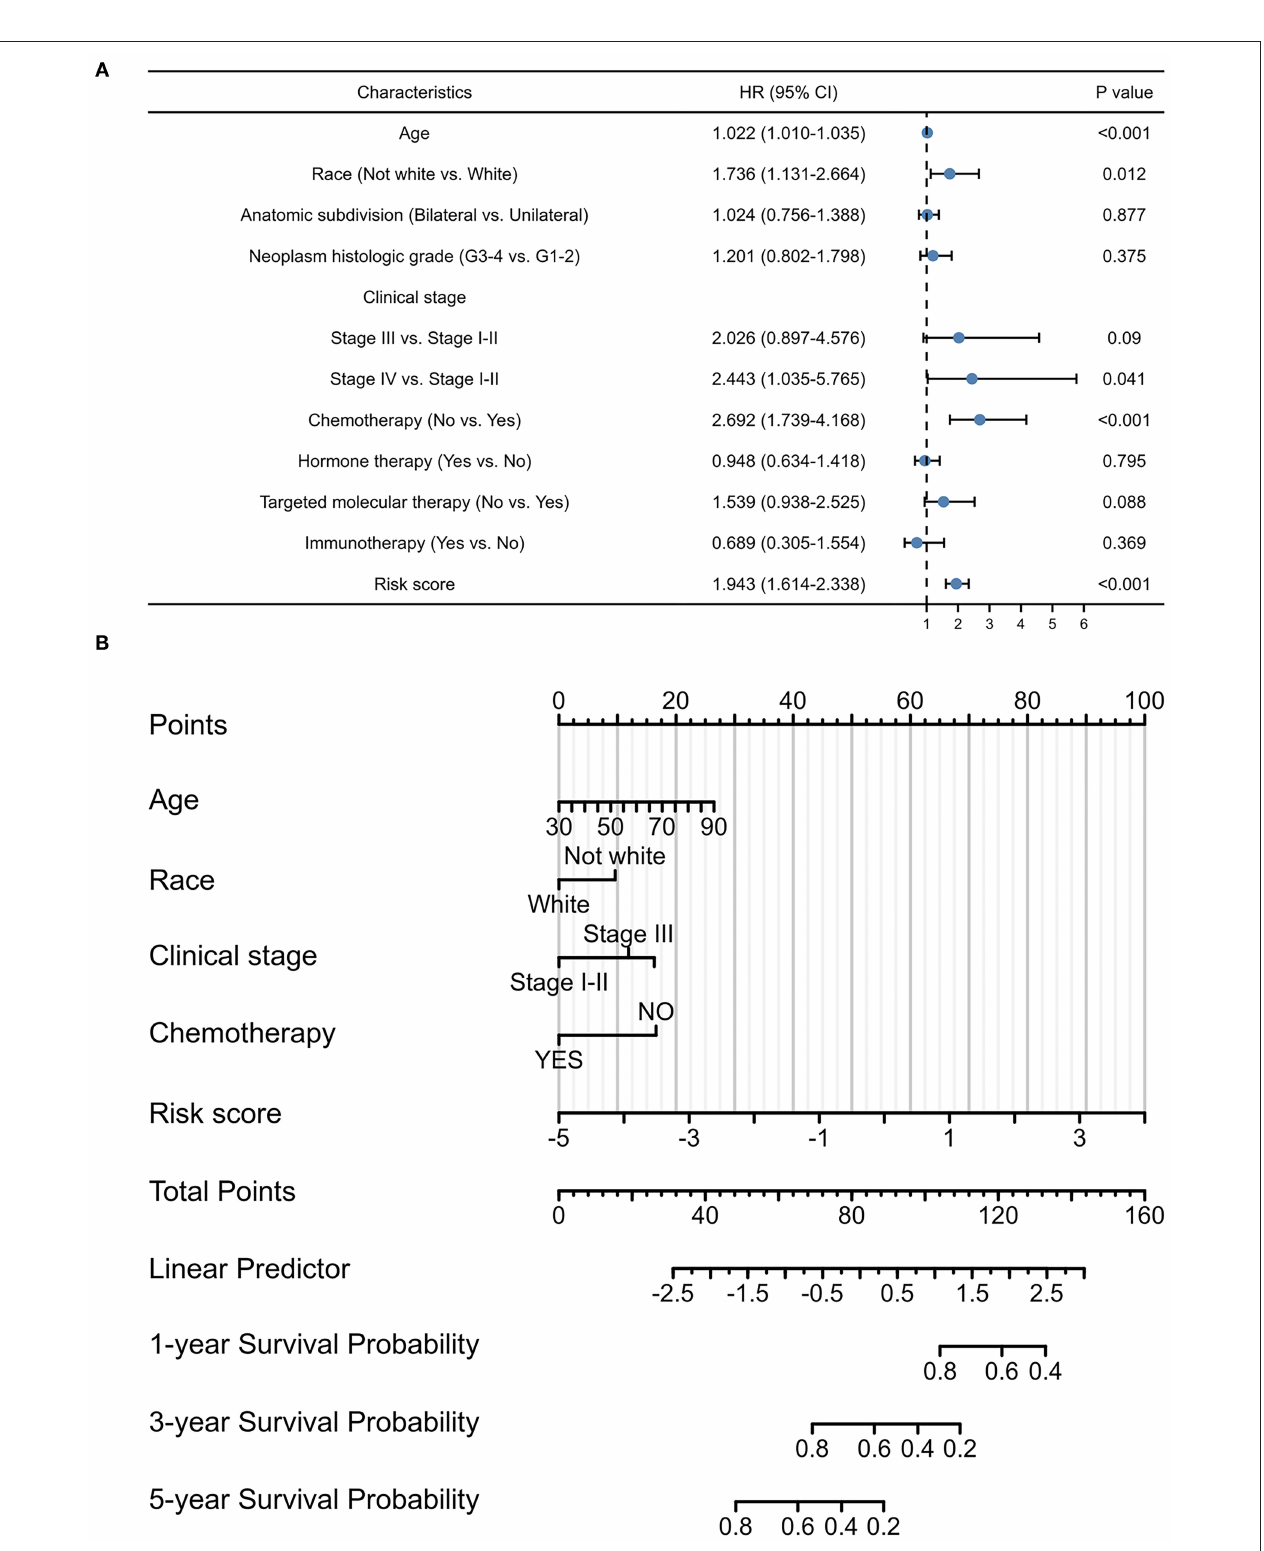
FIGURE 4 | Prognostic values of the pyroptosis-related lncRNA signature. (A) Multivariate Cox regression of patient characteristics and the signature in the whole cohort. (B) Nomogram constructed using patient characteristics and the signature.